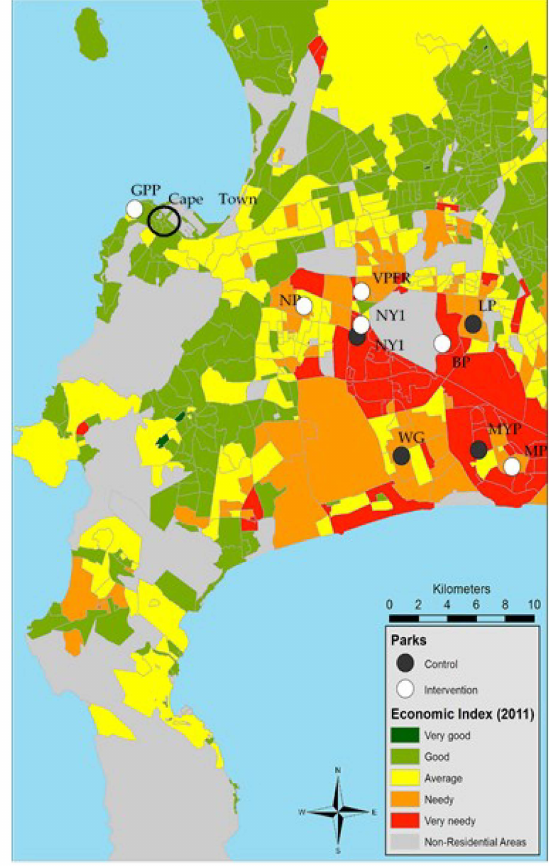
Figure 1. Park location by Economic Index for the city of Cape Town. Note. White-intervention parks (GPP = Green Point Park—higher income suburb, VPFRC = Valhalla Park Family Recreation Centre—lower income suburb, NP = Nantes Park, BP = Blikkiesdorp Park, MP = Mandela Park), black-non-upgraded parks (LP = Longmead Park, WG = Westridge Gardens, MYP = Manyanani Park, NY 144 Park). Source. Information and Knowledge Management Department, City of Cape Town,